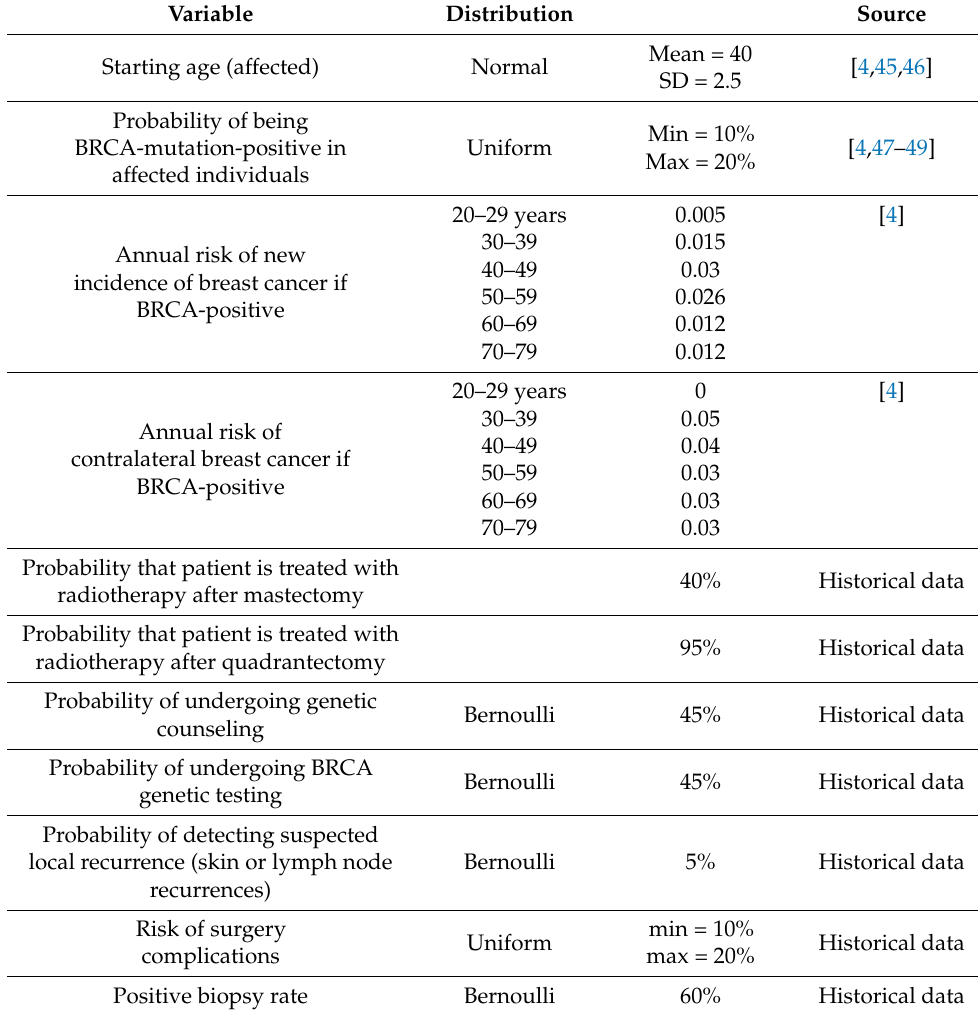
Table 1. Model input parameters: Probabilities.